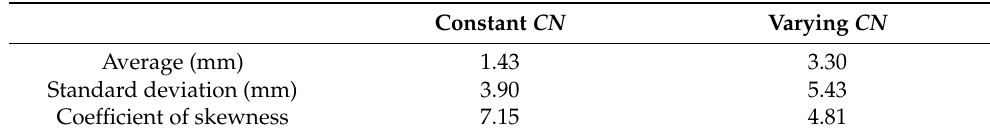
Table 3. Statistical comparison of nonzero runoff data through the NRCS-CN approach for CN II = 60, by considering constant and varying (adjusted to 60 day rainfall) CN